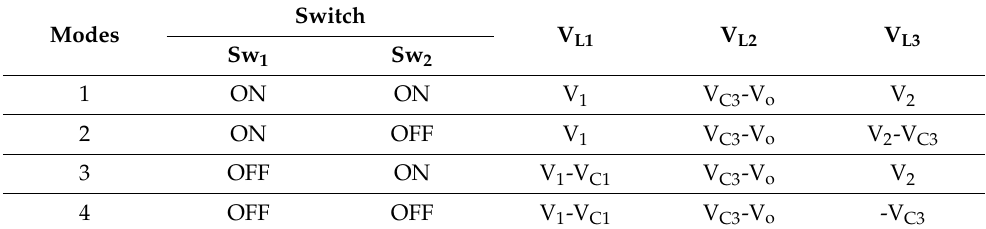
Figure 6. ( a ) S 1 -OFF, S 2 - ON; ( b ) S 1 , S 2 - OFF. Table 3. Demonstration of different